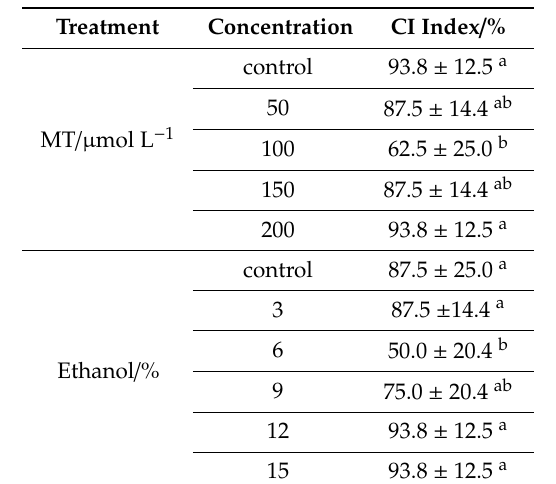
Table 2. E ff ect of melatonin (MT) and ethanol treatment alone on the chilling injury (CI) index of bitter melon fruit after storage at 4 ◦ C for 20 d with a recovery period for 3 d at 25 ◦ C.